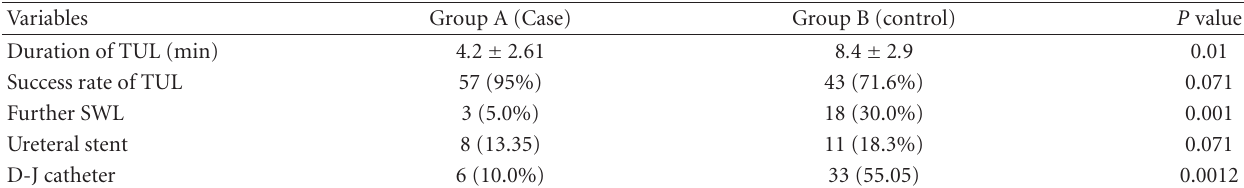
Table 1: Comparison of patients in two groups after